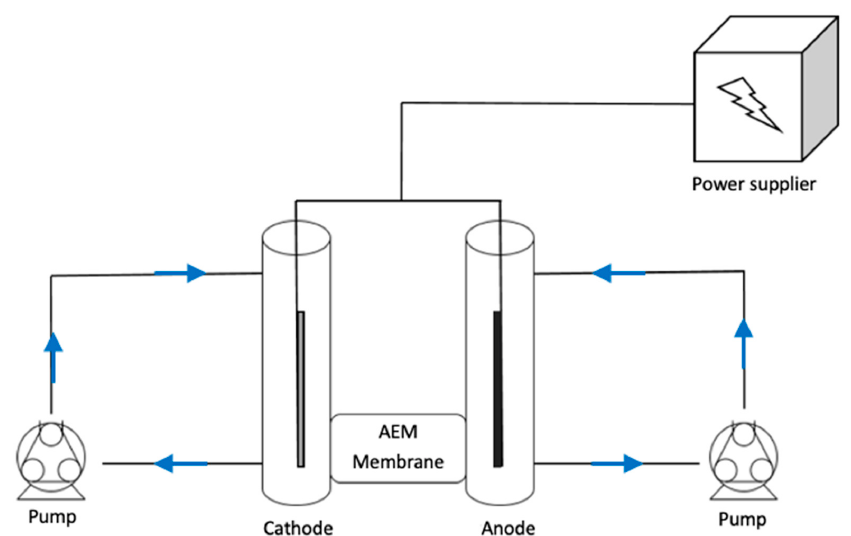
Figure 4. Illustration of the experimental setup of the electrolytic cell in batch mode. The organic acid or broth solution was recirculated between each chamber by peristatic pumps while the electrodes were attached to a power supply to create an electrical driving force from the cathode to the anode chamber. An anionic exchange membrane was inserted between the electrode chambers to ensure a perm-selective extraction of succinic acid and other anions in the solution.